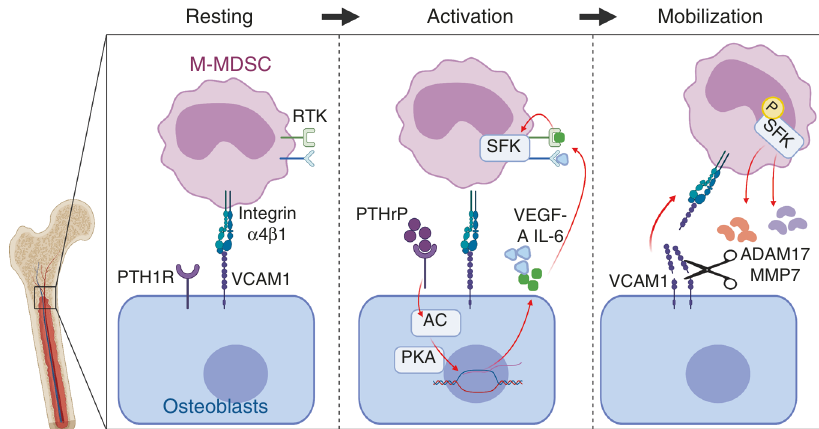
Fig. 9 Schematic illustration of M-MDSC mobilization by PTH1R activation. M-MDSCs reside in the endosteal surface via expression of α 4 β 1 integrin (VLA4) and osteoblastic expression of VCAM1. Tumor-derived PTHrP triggers the PTH1R-adenylate cyclase (AC)-Protein Kinase A (PKA) signaling axis in osteoblasts, and in turn, osteoblasts express VEGF-A and IL6, leading to activating phosphorylation of SFK in M-MDSCs. M-MDSCs subsequently express ADAM17 and MMP7 proteases, followed by shedding VCAM1 and mobilization of M-MDSCs into the circulation. RTK receptor tyrosine kinase. P phosphorylation. Created with